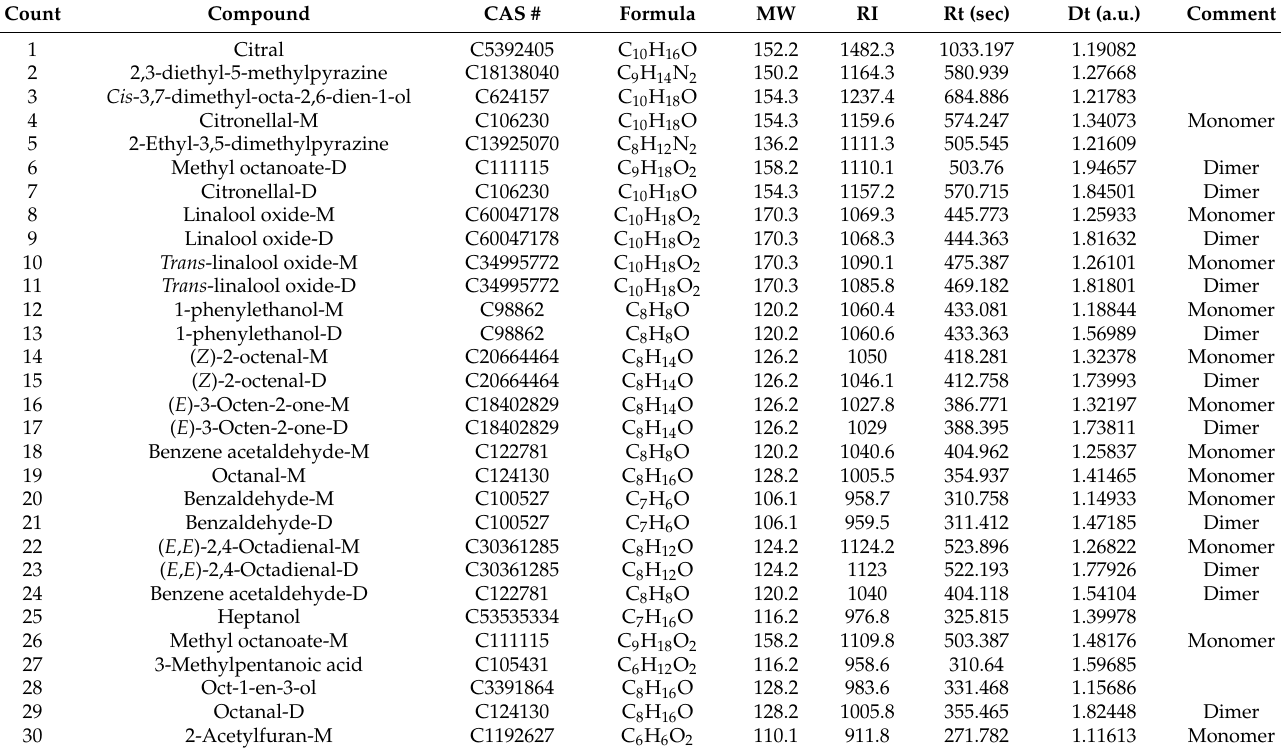
Table 7. HS-GC-IMS integration parameters of volatile compounds in tested honey